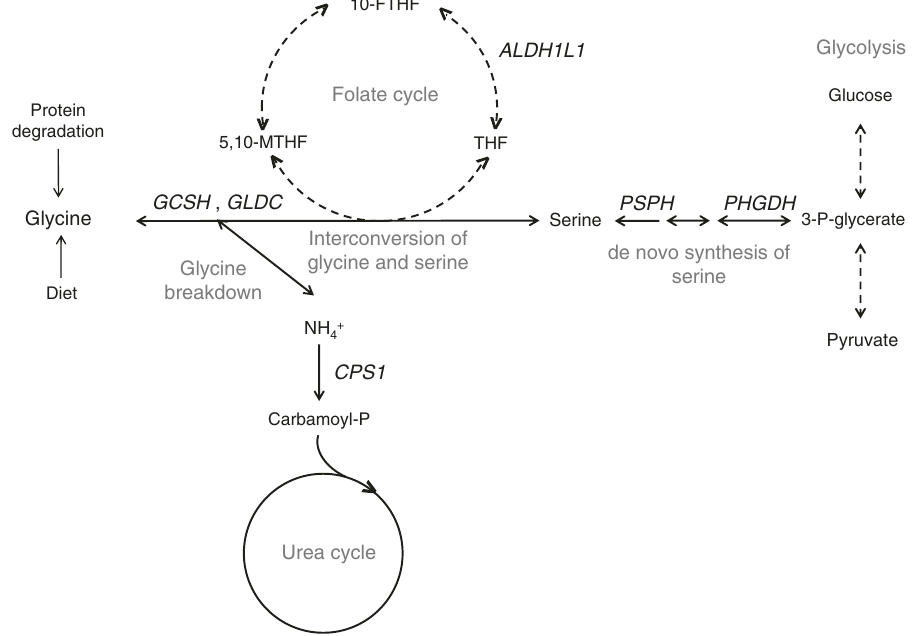
Fig. 2 Schematic overview of glycine metabolism and six genetic loci for glycine in/near genes encoding enzymes related to glycine metabolism. GLDC (glycine decarboxylase) and GCSH (glycine cleavage system protein H) are part of the glycine cleavage system, the major enzyme complex responsible for glycine degradation. PHGDH (phosphoglycerate dehydrogenase) and PSPH (phosphoserine phosphatase) encode enzymes involved in the de novo biosynthesis of serine, which can be converted into and synthesised from glycine. The interconversion of glycine and serine serves as an important source of methyl groups in the folate cycle, a metabolic pathway of which the enzyme encoded by ALDH1L1 (aldehyde dehydrogenase 1 family member L1) is a component. CPS1 (carbamoyl-phosphate synthase 1) encodes the enzyme responsible for the rate-limiting step of the urea cycle which is responsible for the detoxi fi cation of ammonia. Glycine breakdown produces ammonia; changes in the ef fi ciency of the urea cycle are therefore likely to have upstream effects on glycine metabolism. THF: tetrahydrofolate, 5,10-MTHF: N 5 -N 10 -methylenetetrahydrofolate, 10-FTHF: 10-formyltetrahydrofolate Glycine is genetically associated with lower CHD risk . Based on ( γ -glutamylglycine, N-acetylglycine, propionylglycine, N-palmi- toylglycine, isovalerylglycine, serine and cinnamoylglycine) and four were unknown metabolites. Finally, we constructed a 2 SNP score, based on the loci at GCSH and GLDC encoding enzymes of the glycine cleavage system, the major enzyme complex responsible (OR) of 0.95 for CHD. ([95% con fi dence intervals (CI)] = [0.92, for glycine breakdown. The 2 SNP score explained 0.6% of the 0.98], p based on two-sided t -test: p = 0.001) (Fig. 4, Supple- variance in glycine and was associated with γ -glutamylglycine, mentary Table 2). Sex-speci fi c analyses in up to 9852 female and N-acetylglycine, propionylglycine, isovalerylglycine, 21,994 male CHD cases showed that the effect sizes of glycine on 3-methylglutaconate and its carnitine conjugate, and one unknown CHD risk were similar in women and men ( p for sex difference metabolite (Supplementary Data 4). based on two-sided t -test: p sex = 0.60) (Fig. 4 and Supplementary